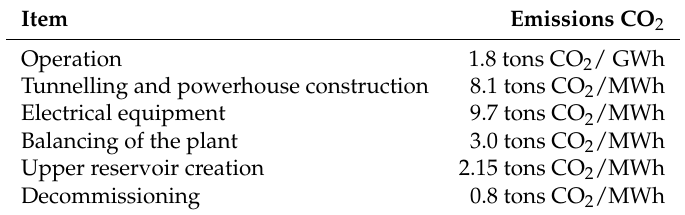
Table 4. Estimation of the greenhouse gas emissions (GHG) emissions per MWh of storage capacity.